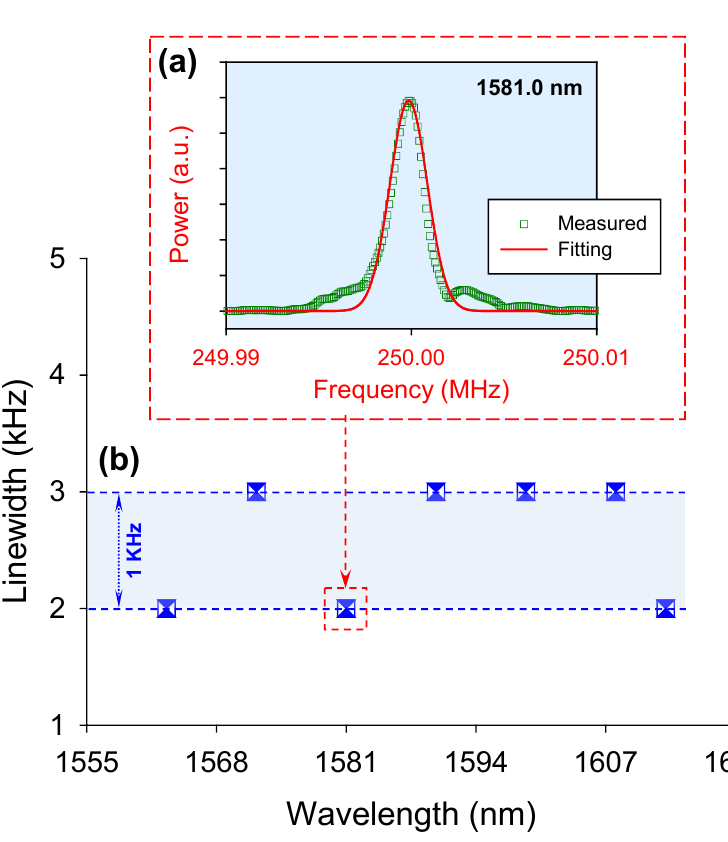
Figure 5. ( a ) Observed linewidth spectra of measured data and Lorentzian fitting at the wavelength of 1581.0 nm. ( b ) Obtained 3 dB Lorentzian linewidth over the tuning range of 1563.0 to 1613.0 nm.